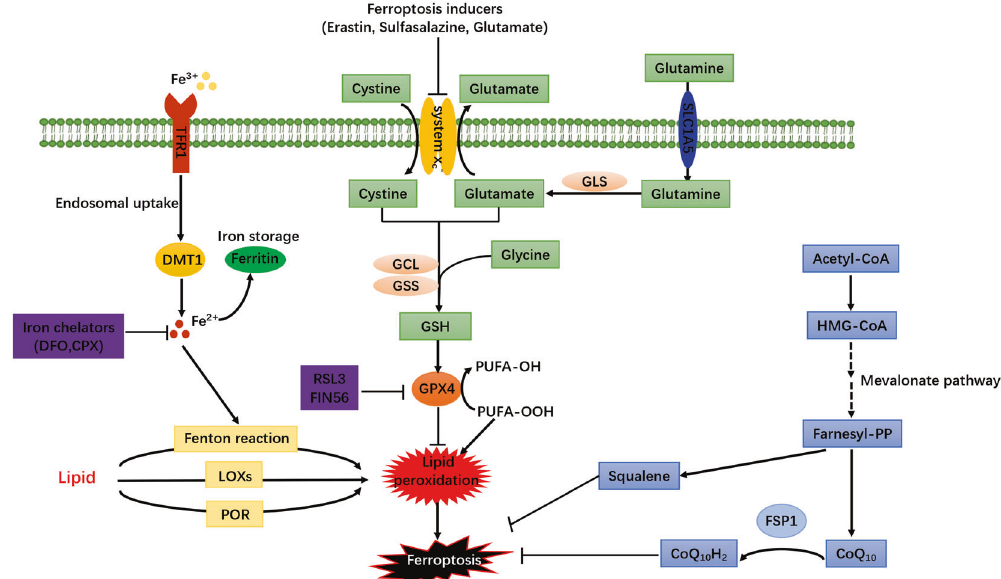
Fig. 1 The regulatory pathways of ferroptosis. Ferroptosis is triggered by the excessive lipid peroxidation (LPO). Cysteine and reduced glutathione (GSH) availability are regulated by cystine-glutamate antiporter system X c – or the transsulfuration pathway. The transsulfuration pathway is a metabolic pathway for the production of cysteine (Cys)-containing amino acids and the synthesis of GSH through the interconversion of cysteine and homocysteine. Glutamine can be transported into intracellular places by SLC1A5 transporter, and then converted into glutamate by glutaminase (GLS) to affect the GSH availability. GSH is a key cofactor of GPX4 for clearing lipid peroxides. The suppression of system X c − by erastin or GPX4 activity by RSL3, which ultimately leads to cell ferroptosis. On the one hand, the peroxidation of PUFAs and excess irons is considered to be an important contributor. Iron uptake via the transferrin receptor-like TFR1 or degradation of ferritin iron stores enhances the labile iron pool, thereby cells are susceptible to ferroptosis via lipid hydroperoxides generation from the Fenton-like reaction. In addition, the mevalonate pathway is also involved in ferroptosis process by generating a series of biomolecules with potential anti-ferroptotic activity such as squalene, coenzyme Q10 (CoQ10), isopentenyl- pyrophosphate (IPP), and farnesyl pyrophosphate (FPP), which in part in fl uences the ferroptosis occurrences. POR cytochrome P450 oxidoreductase, LOX